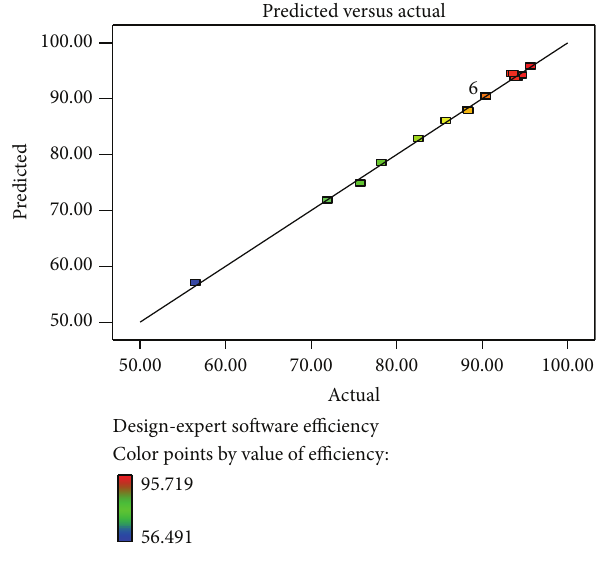
Figure 1: Actual-predicted plot for response 𝑌 1 . Figure 2: Actual-predicted plot for response 𝑌